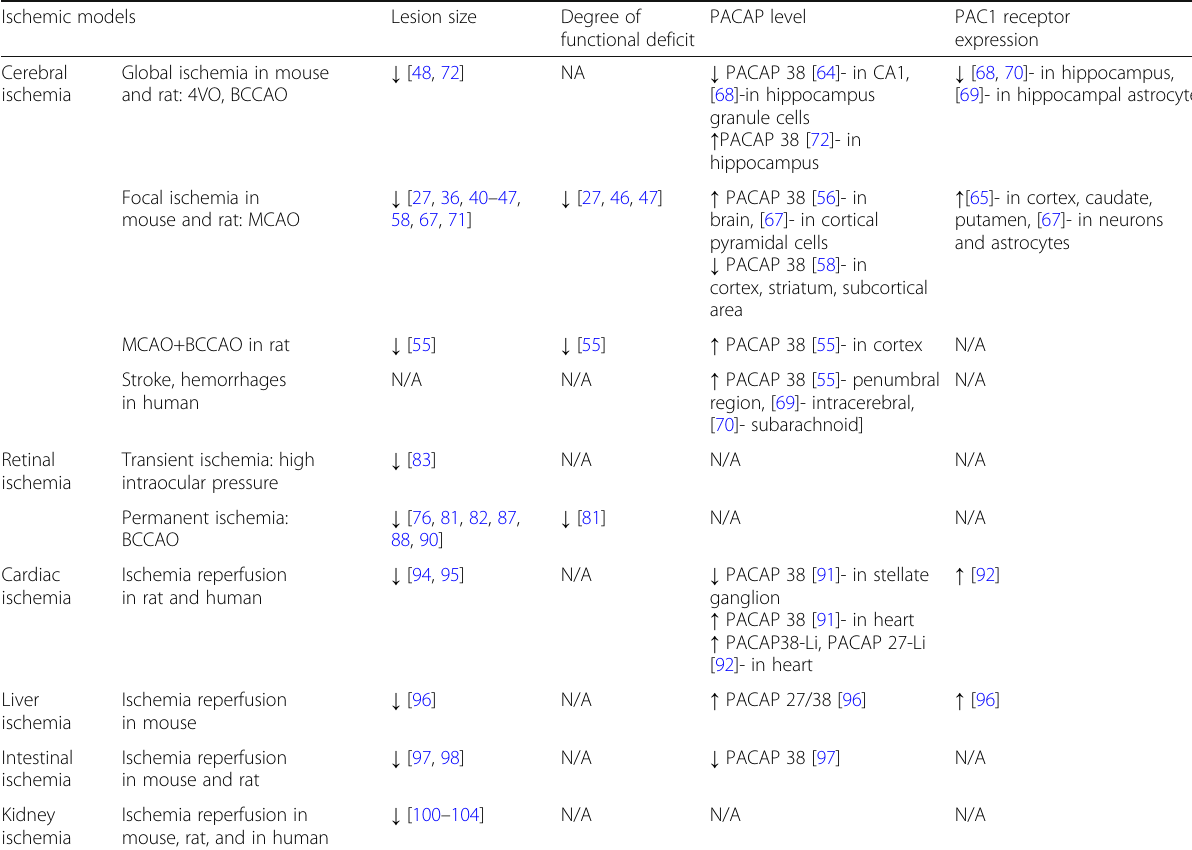
Table 1 Summary of the protective effects of PACAP in different ischemic models, human diseases and changes of PACAP levels and PAC1 receptor expression in ischemic conditions Ischemic